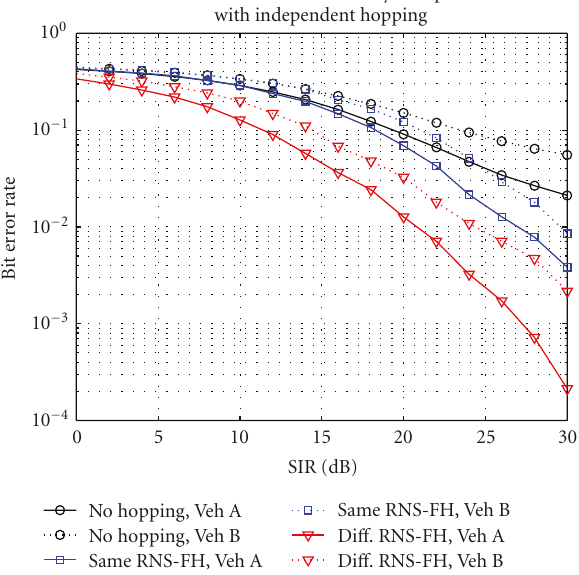
Figure 10: BER versus SIR of RNS-FH OFDMA under independent hopping with di ff erent channel conditions. N = 110, M = M c = 10, N c = 11, SNR = 25dB, f D T s = 0 . 01.